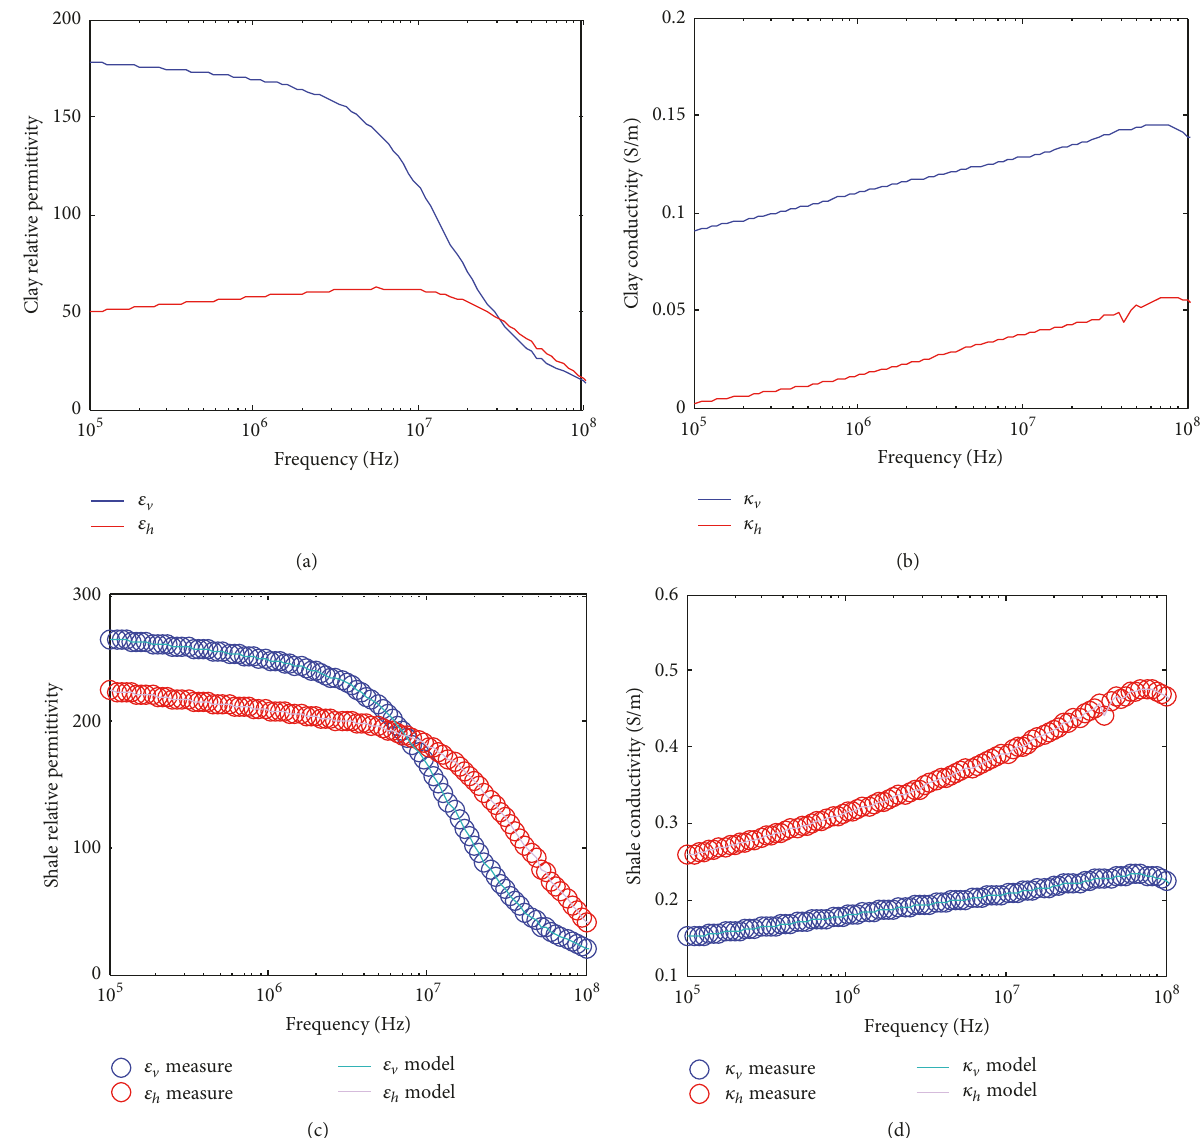
Figure 5: Inverted frequency dependent relative permittivity (a) and conductivity (b) of the wet kaolinite and comparison of the laboratory measured relative permittivity (c) and conductivity (d) of the shale sample A0100 75 with the model prediction based on the wet kaolinite properties in the vertical and horizontal directions,